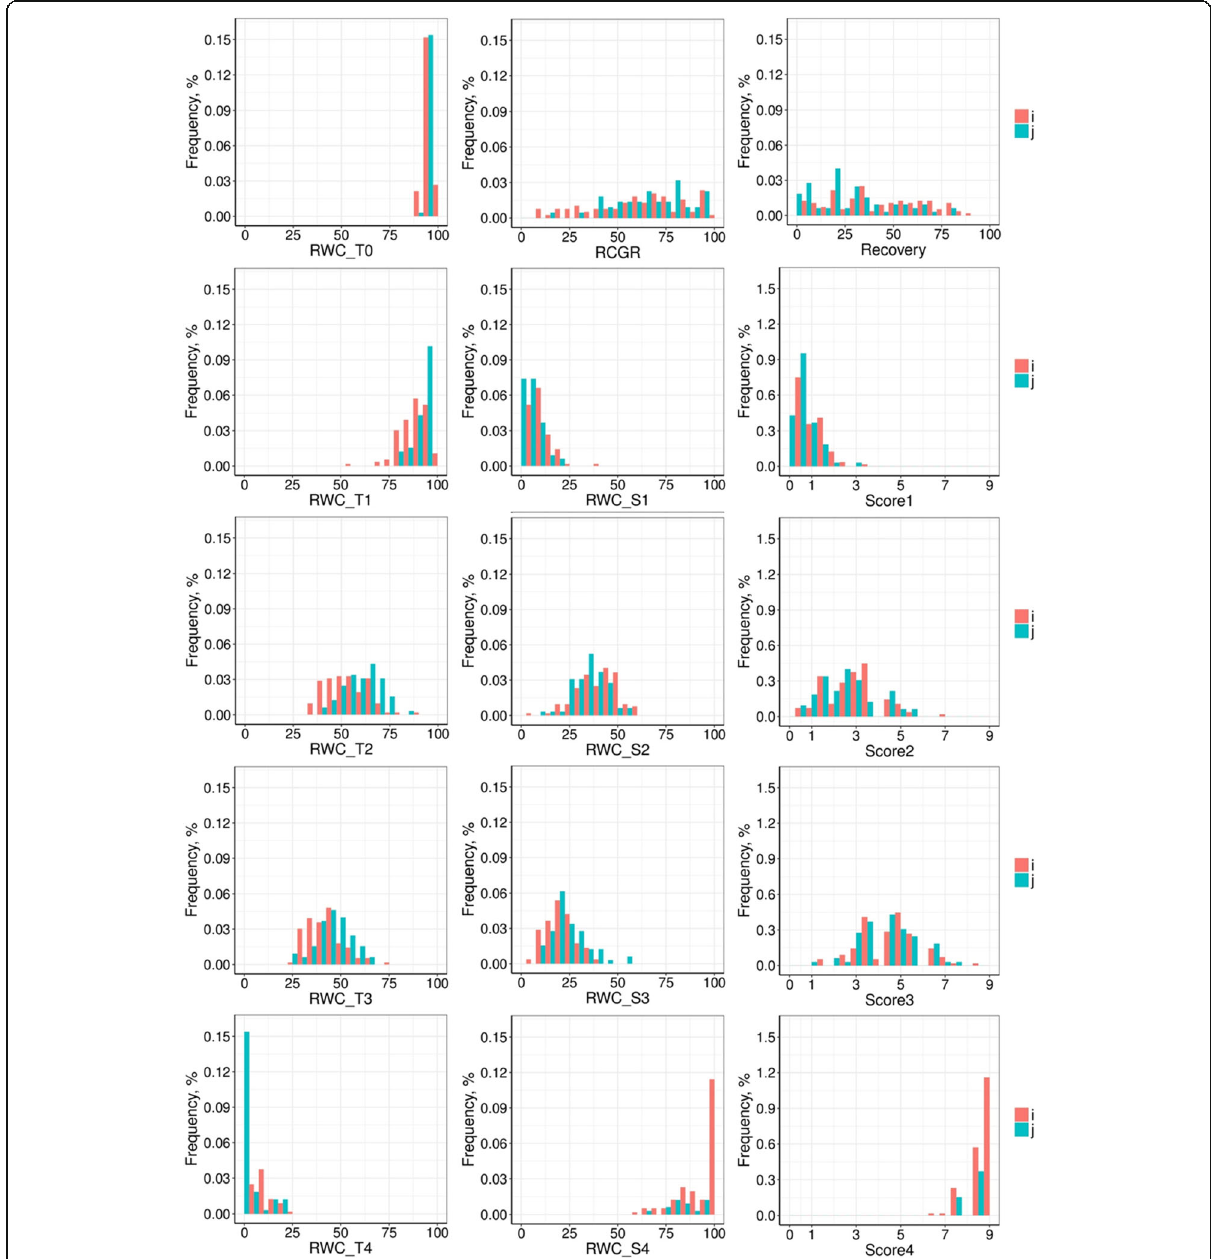
Fig. 2 Frequency distribution of calculated traits. Indica subpanel (I) in red; japonica (J) subpanel in blue; RWC_T0, relative water content before drought treatment; RWC_T1 to RWC_T4, relative water content after 1 to 4 weeks of drought stress; RWC_S1 to RWC_S4, slope of relative water content after 1 to 4 weeks of drought stress; Score1 to Score4, drought sensitivity score after 1 to 4 weeks of drought stress; Recovery, recovery ability; RCGR, relative crop growth